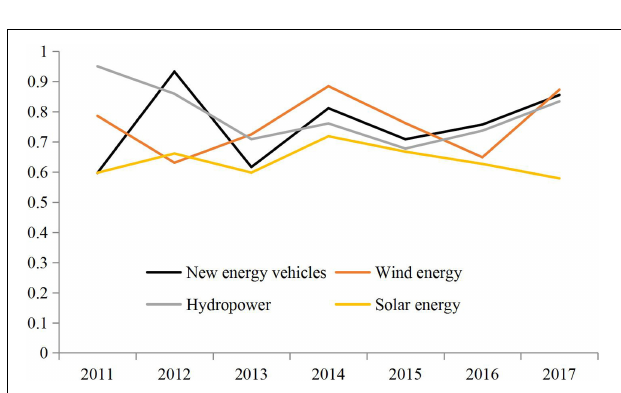
FIGURE 8 | Comprehensive correlation between the efficiency of the four new energy industries and Balance.